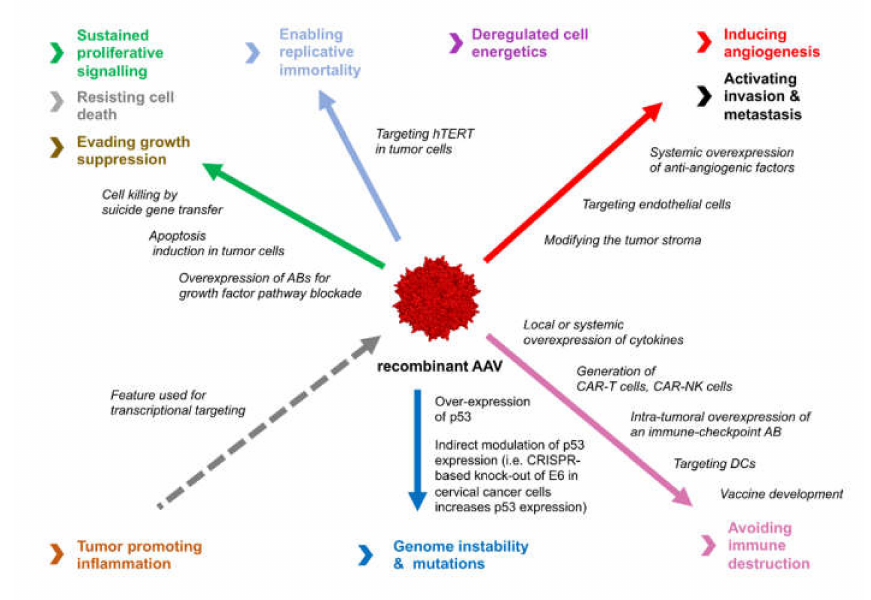
Figure 2. Key strategies of AAV vector-based cancer therapy, applied in preclinical studies so far,